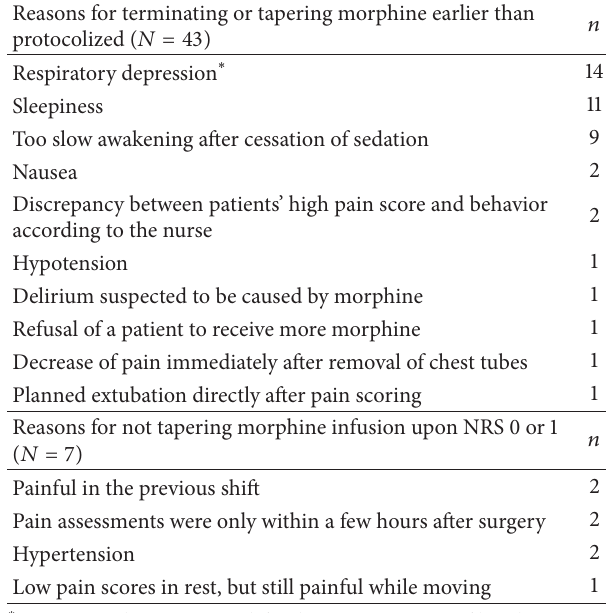
Table 2: Reasons for deviating from the protocol. Reasons for terminating or tapering morphine earlier than protocolized ( 𝑁 = 43